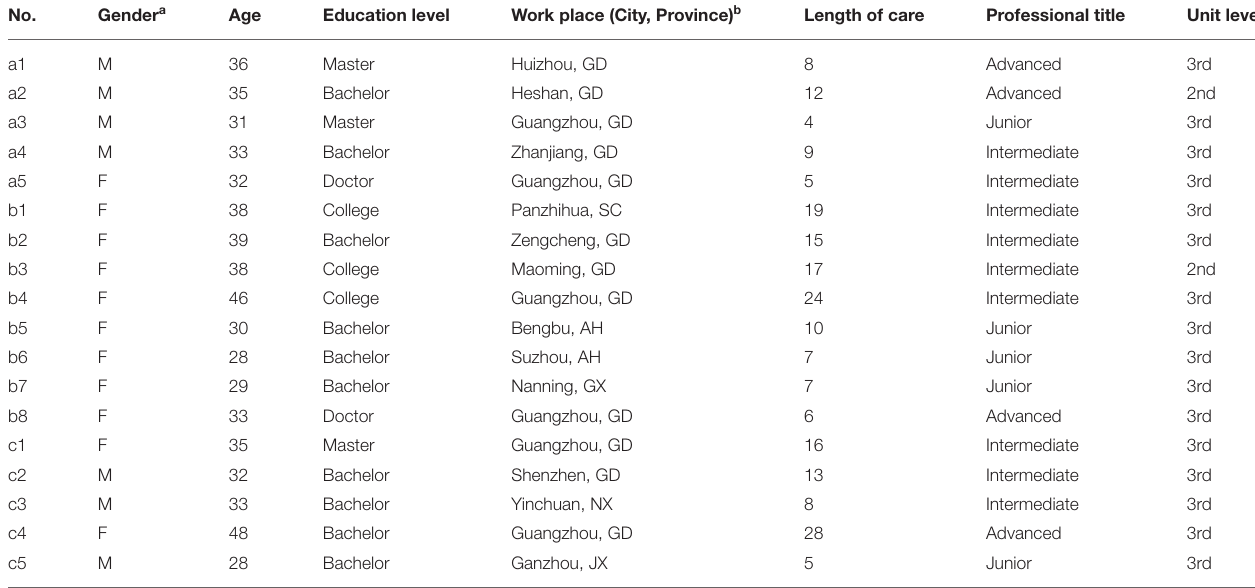
TABLE 2 | Characteristic of